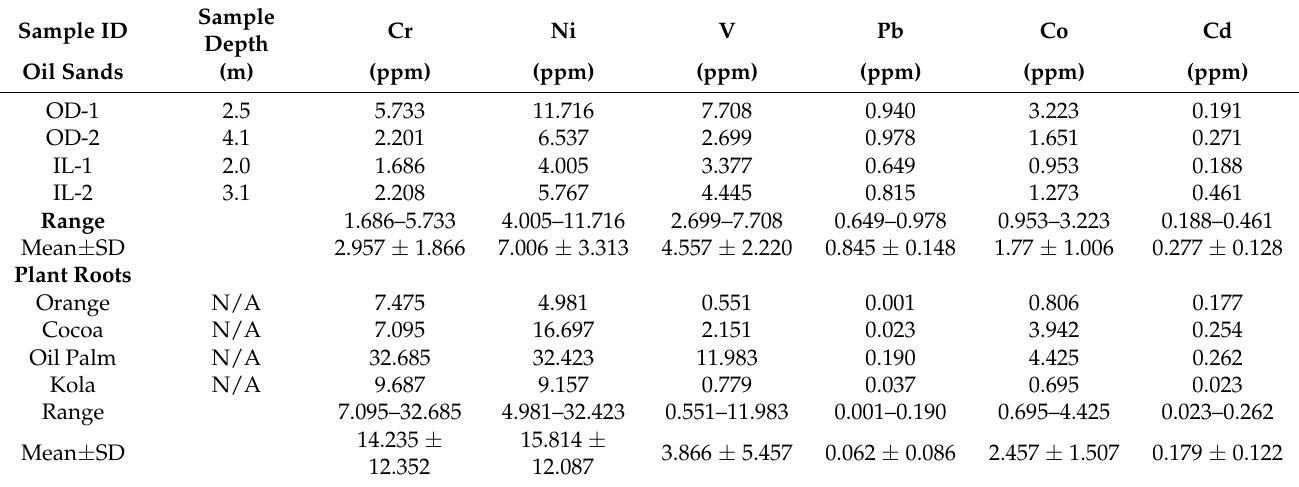
Table 3. The concentration of chromium (Cr), nickel (Ni), vanadium (V), lead (Pb), cobalt (Co), and cadmium (Cd) in oil sands and plant roots.